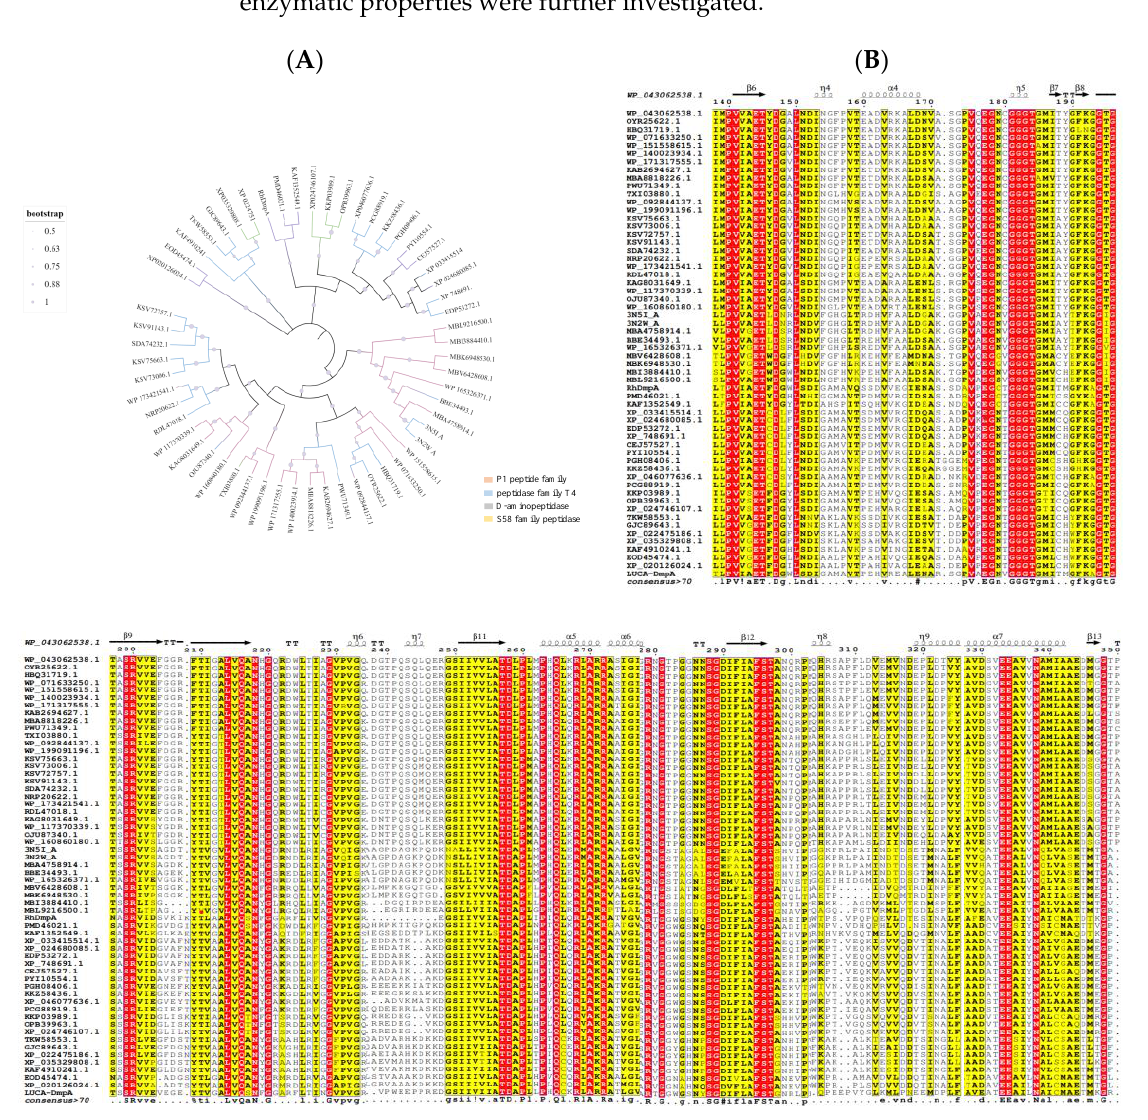
Figure 1. The maximum likelihood phylogenetic tree and multiple sequence alignments of protein sequences. ( A ) The phylogenetic tree was constructed via the maximum likelihood method using PhyML v 3.0. The simplified phylogenetic tree is presented as Supplementary Data (Figure S1). ( B ) Multiple sequence alignments of protein sequences performed using Clustal X 2.1 and visualized using ESPript 3.0 (WP_043062538.1 as